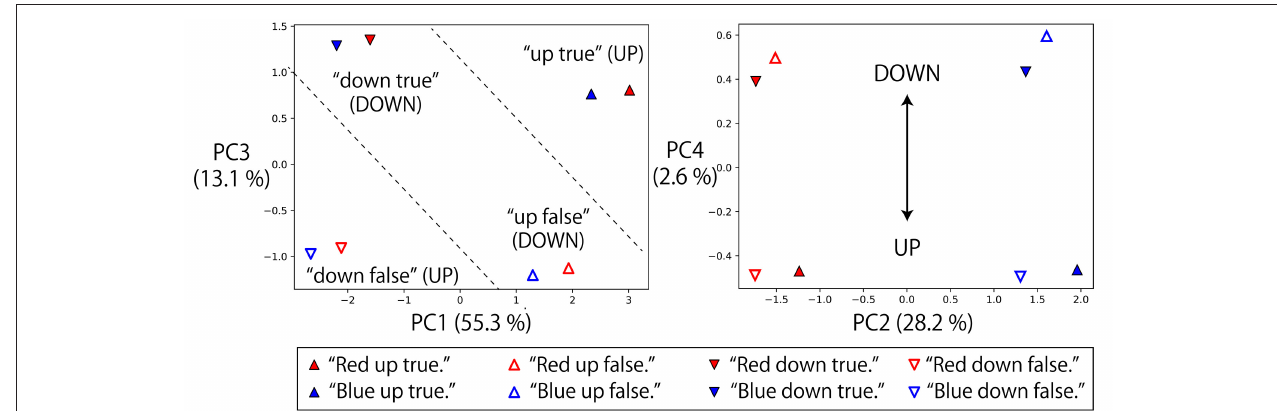
FIGURE 7 | Memory cell states after giving eight possible instructions with one objective word to the RNN in the situation that the grasped flags are R-B and the waiting posture is DOWN-DOWN. The left panel projects them onto PC1–3 space, and the right panel projects them onto PC2–4 space. In the directions of PC1, PC2, and PC3, the activations directly corresponding to each part of speech (objective, verb, truth value) can be seen: that is, “red”/“blue”, “up”/“down” and “true”/“false” pairs are reflected in the PC2, PC1, and PC3 axes, respectively. However, by exploring lower rank components, it can be seen that the X-OR problem consisting of “up”/“down” and “true”/“false” pairs is solved in the PC4 direction by non-linearly embedding the input sentences.